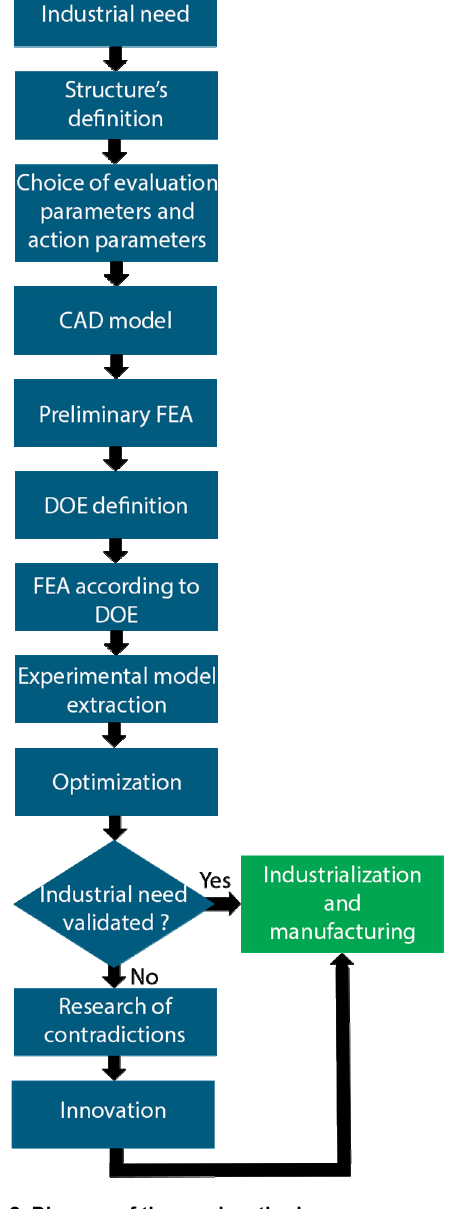
Figure 2. Diagram of the used method To choose the values of the variable geometrical parameters ( T 1, T 2 and L ) in the DoE, preliminary tests were performed with numerical simulations to check the convergence of the analysis. The finally chosen values of the geometrical parameters are (in millimeters):